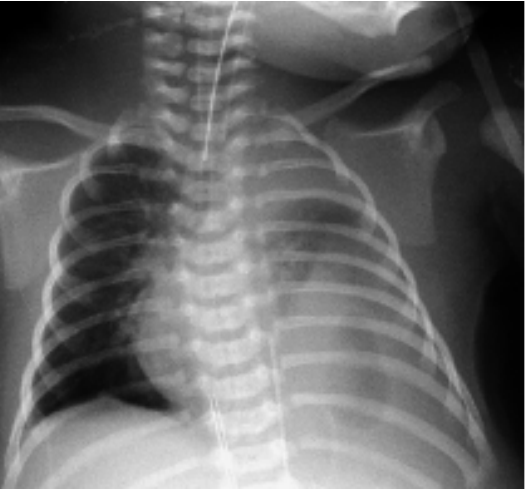
Congenital diaphragmatic hernia (CDH). Chest radiograph of a 14-year-old girl showing a moderately dense tumour at the right cardiophrenic angle that turned out to be right- sided Morgagni hernia. The girl presented with slowly re- solving pneumonia in the right lower